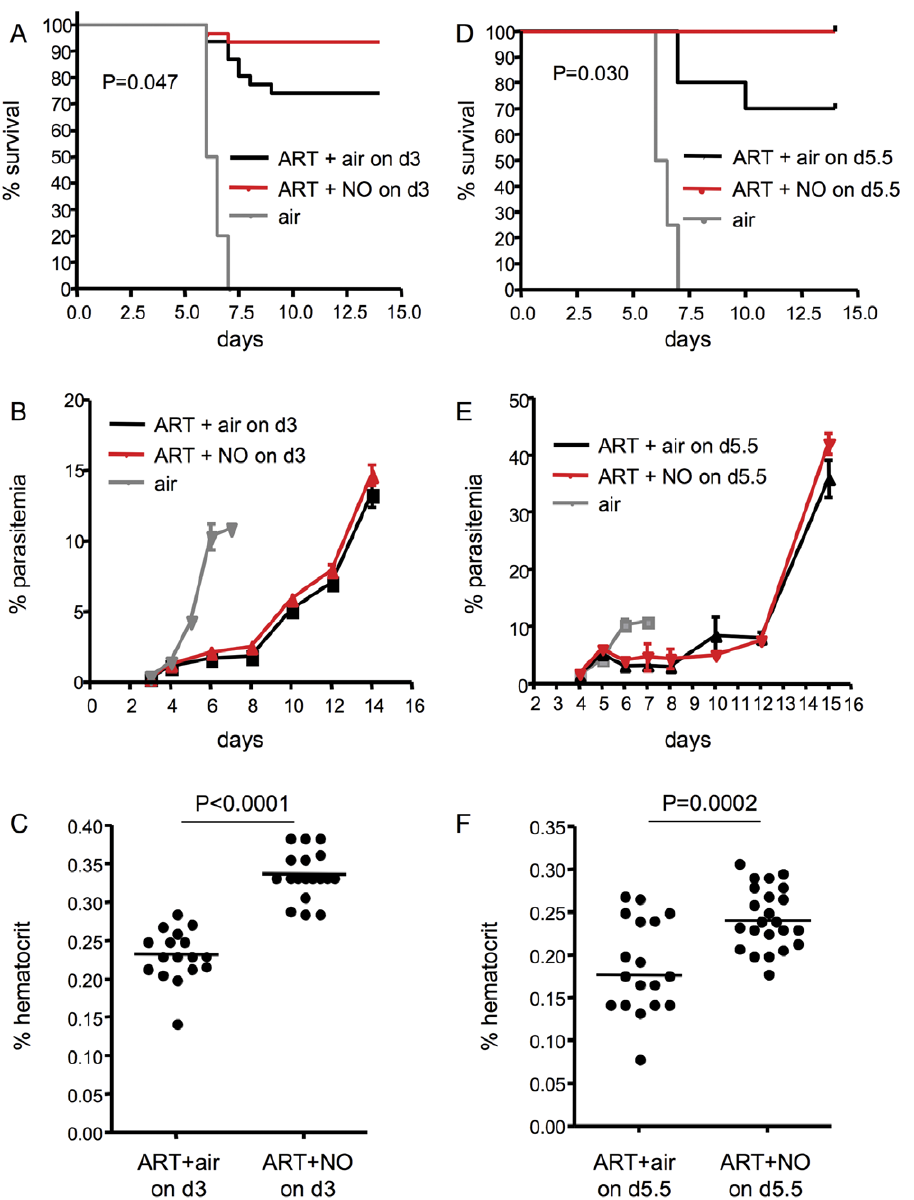
Figure 6. Inhaled NO administered in combination with artesunate confers a survival advantage over artesunate treatment alone in experimental CM. Mice were infected with P. berghei ANKA and were treated with either medical air (grey line), 10mg/kg artesunate (black line), or 10mg/kg artesunate plus 80 ppm NO (red line) starting on day 3 (A-C) or day 5.5 (D-F) post infection. Artesunate was given once daily by i.p. injection for 4 days starting on day 3, or once daily for one day starting on day 5.5. Air or 80 ppm NO was initiated on day 3 or day 5.5 and continued until the end of the experiment on day 15 post-infection. (A and D) Survival was monitored twice daily. Significant differences in survival were assessed by Log rank test. For Day 3: p=0.049 for ART + air vs. ART + NO, n=31 for ART + air, n=30 for ART + NO, and n=10 for air alone. For Day 5.5: p=0.031 for ART + air vs. ART + NO, n=10 for ART + air, n=14 for ART + NO, and n=8 for air alone. (B and E) Parasitemia did not differ significantly between the ART + air and the ART + NO groups. (C and F) Hematocrit was assessed on day 14 of infection in mice receiving ART + air or NO starting on day 3 (C)